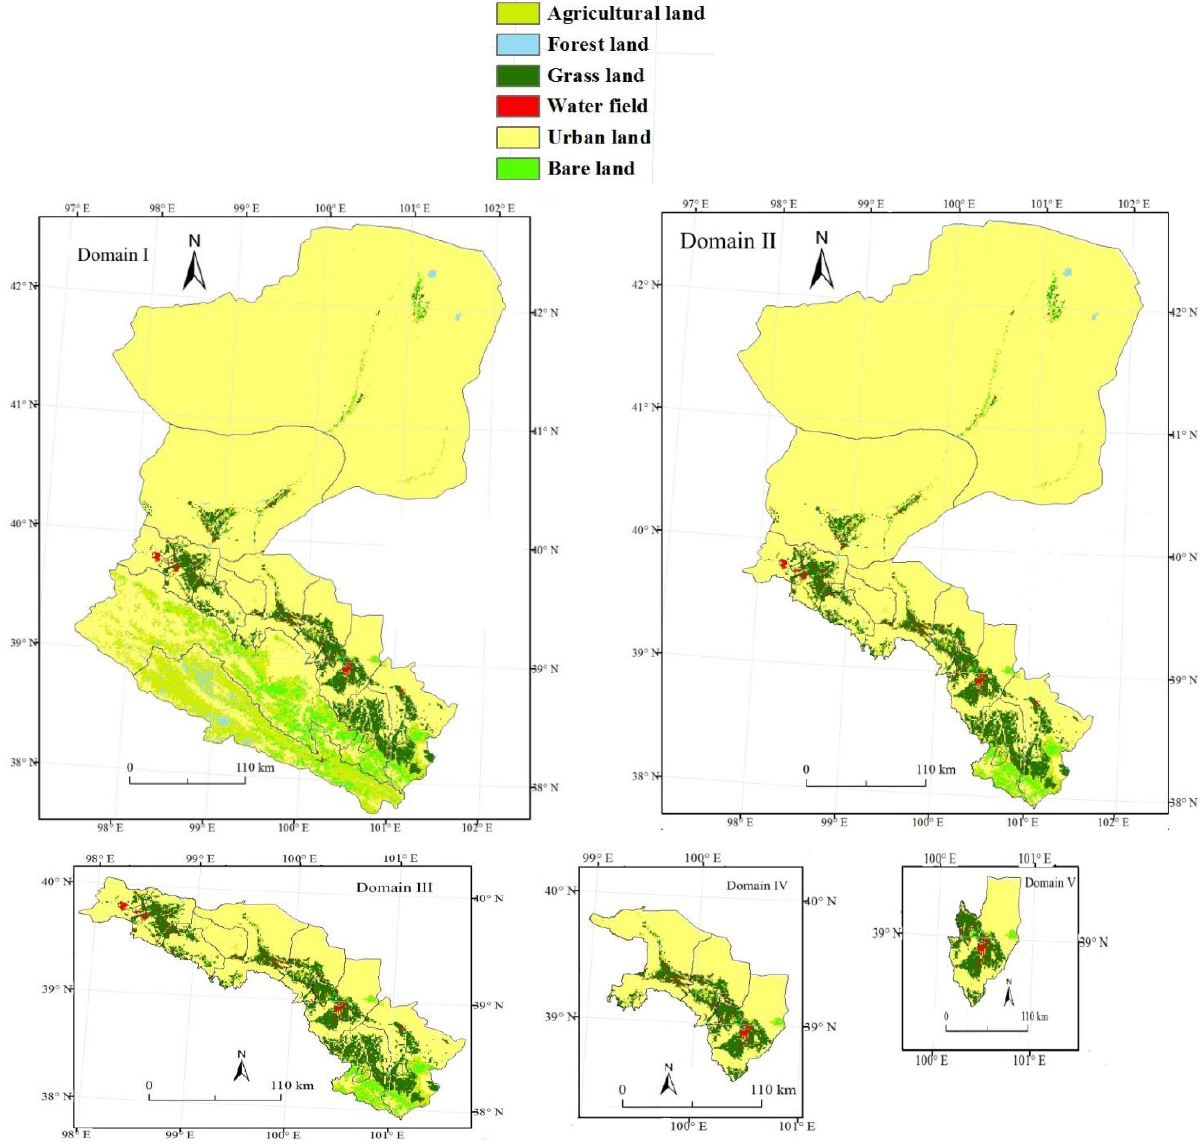
Figure 3. Land cover maps of the five domains in Heihe River Basin ( a ) Domain